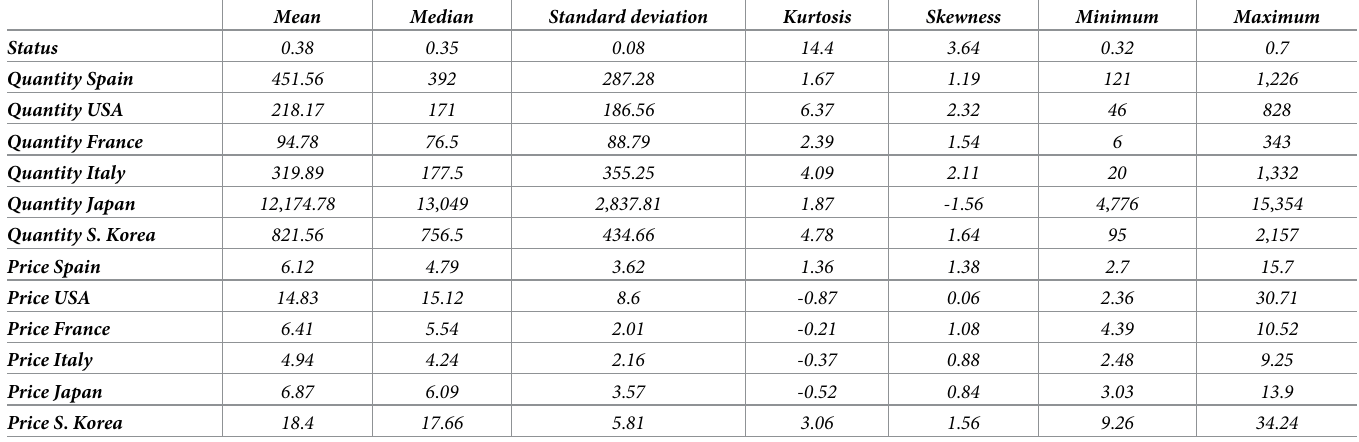
Table 3. Main descriptive